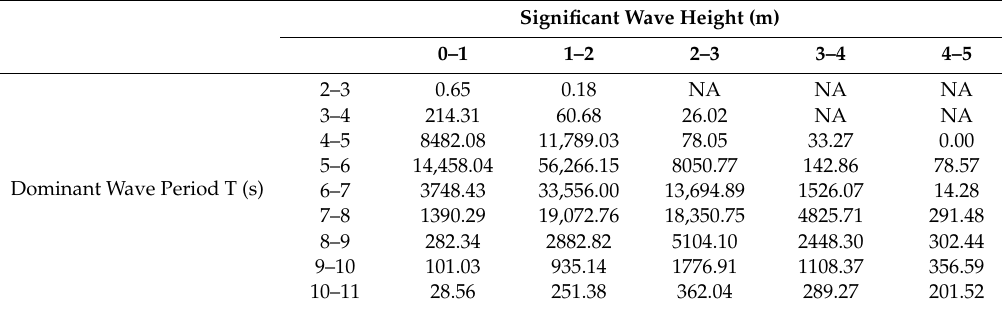
Table 6. Annual energy capture of the non-self-adjustable wave energy